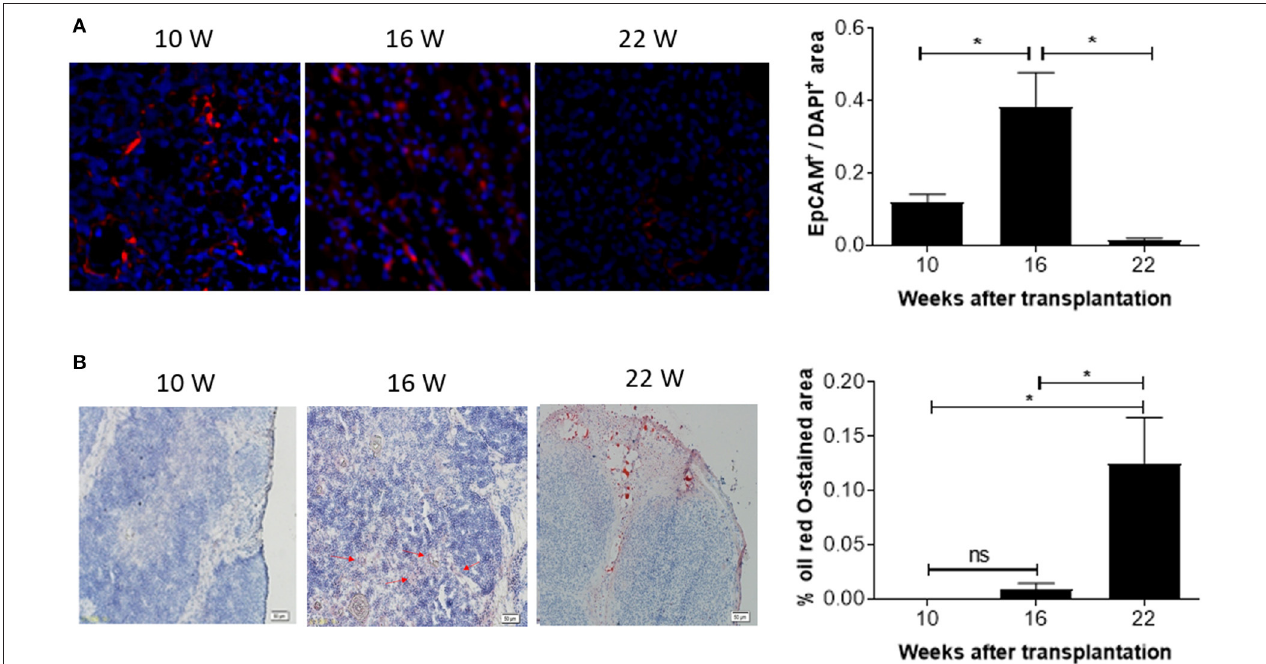
FIGURE 4 | Kinetic changes in EpCAM + TECs and fat-deposition in human thymic grafts from hu-mice. Tissue sections of human thymic grafts prepared from hu-mice at weeks 10, 16, and 22 were stained with anti-EpCAM antibody and DAPI ( A ; n = 3–6 at each time point) or with Oil Red O and Hematoxylin ( B ; n = 4–5 animals at each time point). (A) Images of representative samples (left) and ratios of EpCAM + to DAPI + areas (right). (B) Images of representative samples (left) and percentages of Oil Red O-stained areas (right). Data are presented as mean ± SEM. * p < 0.05.